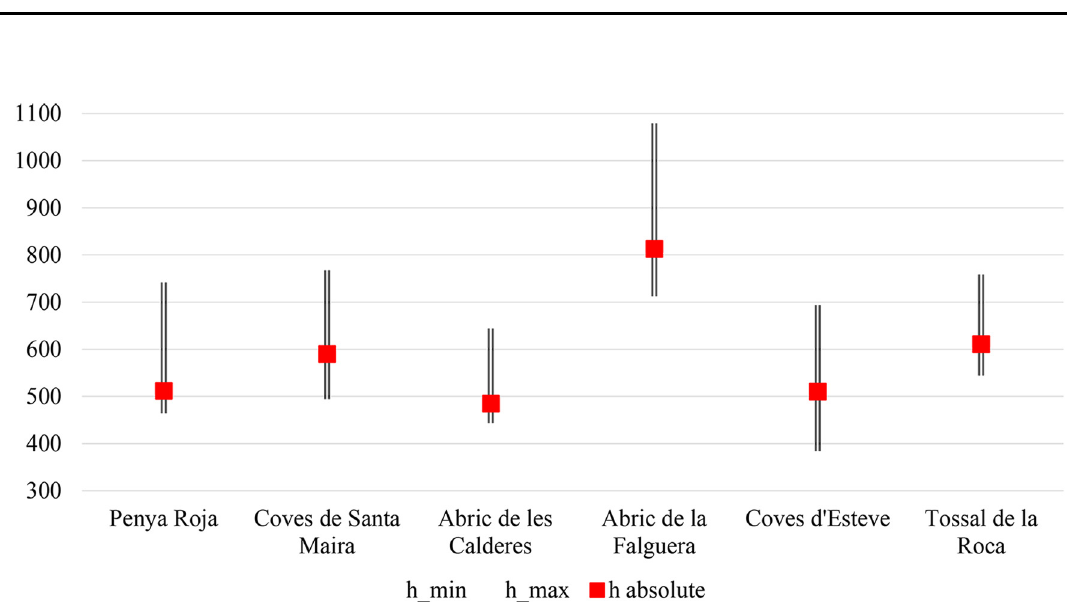
Figure 5: Graphical representation of prominence